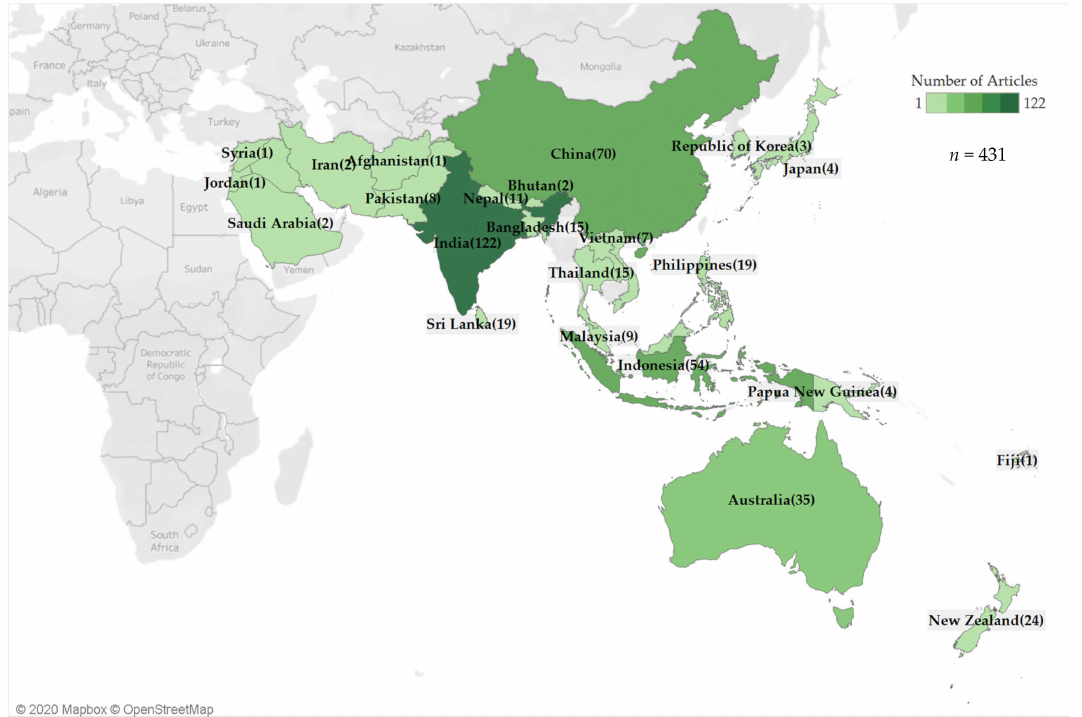
Figure 3. Geographic distribution of the selected articles on agroforestry practices and ecosystem services. Note: The darker the color of the green, the higher the number of the articles focusing on agroforestry practices and ecosystem services in the Asia-Pacific